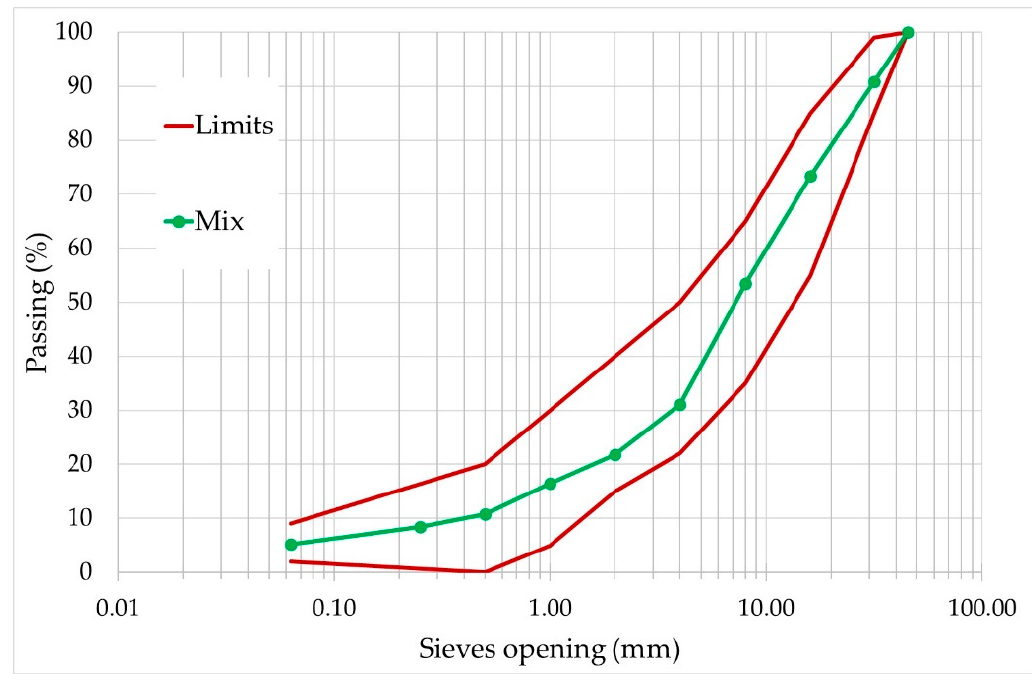
Figure 5. Particle size distribution and grading envelope 0/31.5 GA for unbound bases of CDW.